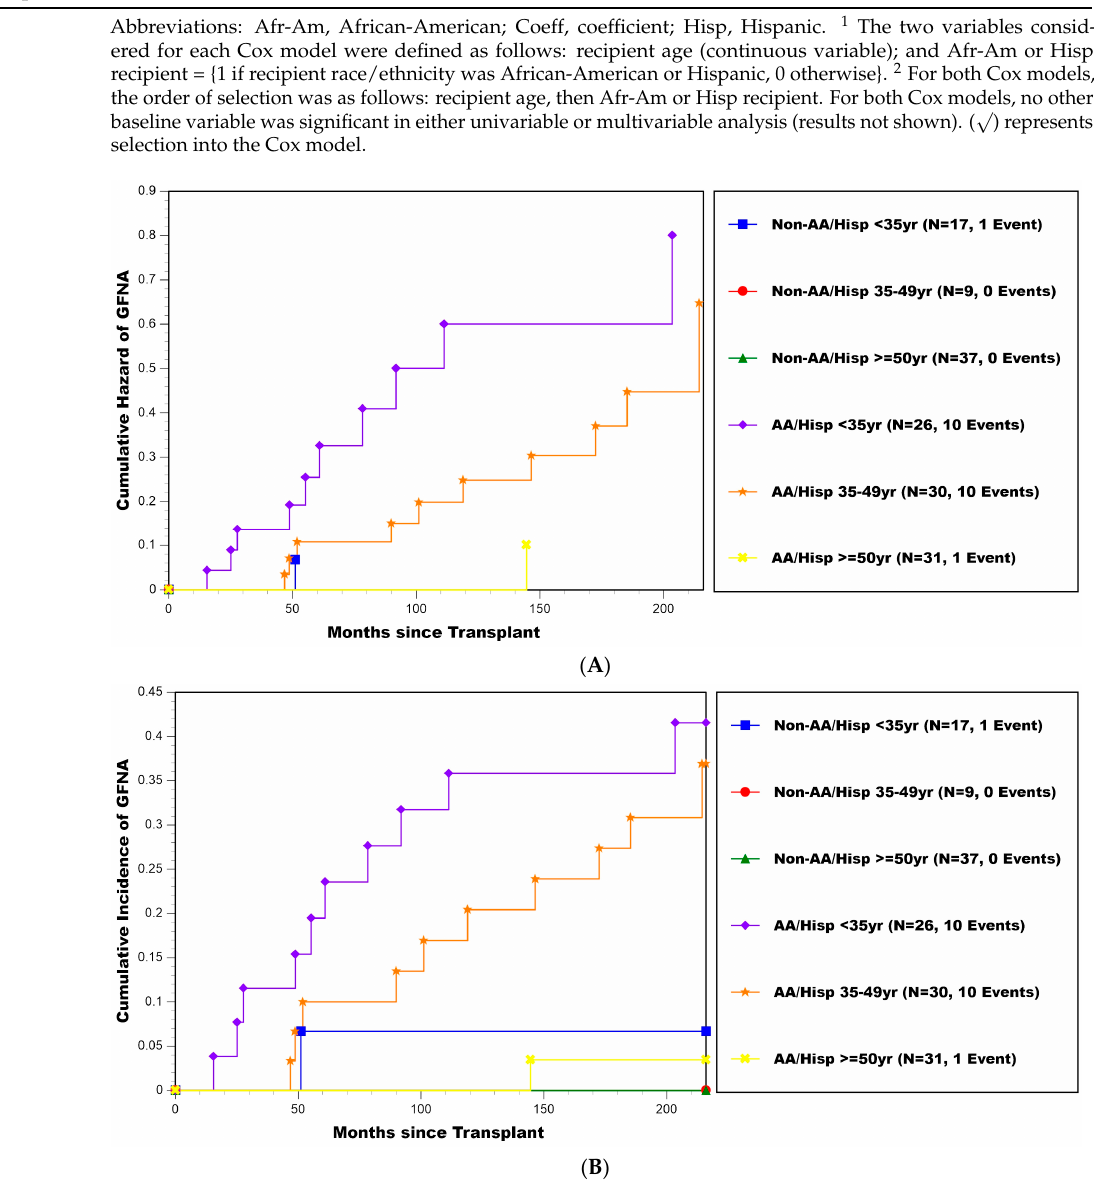
Figure 3. ( A ) Cumulative hazard plot of GFNA for patients stratified by recipient age at transplant (<35, 35–49, and ≥ 50 years) and race/ethnicity (African-American or Hispanic vs.